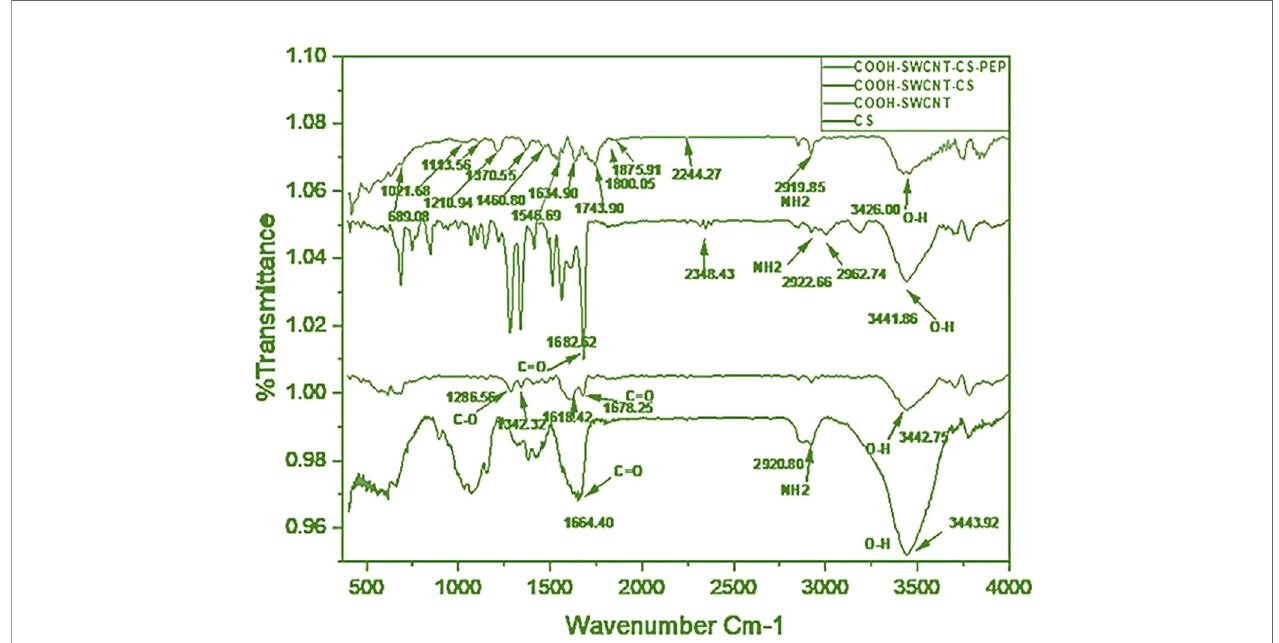
FIGURE 1 | FTIR of CS (chitosan), COOH-SWCNT (single-walled carbon nanotubes), COOH-SWCNTCS (single-walled carbon nanotubes with chitosan), COOH- SWCNTCSPePs (Chitosan-carbon nanotubes with